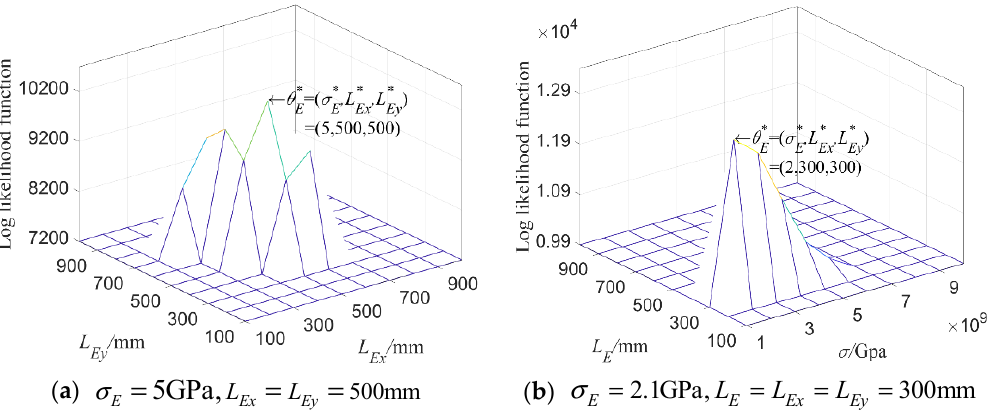
Figure 14. ˆ L ( θ ) of the first 6 natural frequencies when inputting different parameter settings θ E . It can be seen from Figure 14 that the parameter settings θ ∗ . E to the maximal value ˆ L ( θ ) are, respectively, θ ∗ and ( 2GPa, 300mm, 300mm ) ; based on the multi-dimensional kernel density estimation, parameter settings of test samples can be accurately estimated when the log likelihood function attains its maximal value and the estimated parameter settings are very close to the input parameters of the test samples, which verifies the validity of the constructed